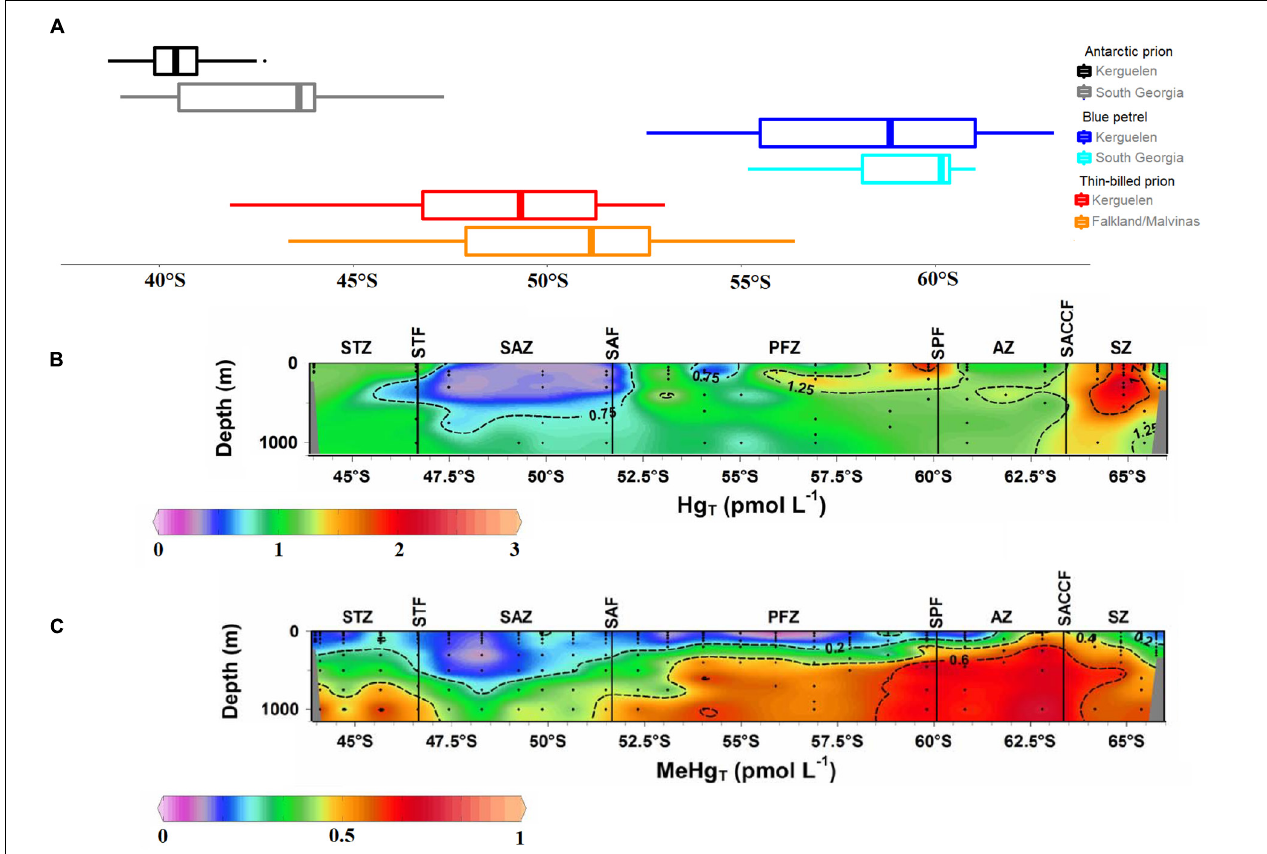
FIGURE 2 | (A) Latitudinal distribution of geolocator tracked Blue Petrels, Thin-billed Prions, and Antarctic Prions during the mid-winter months (June to August), and a mercury transect shown for comparison: (B) total mercury and (C) methyl mercury concentrations along a transect from Hobart to the Antarctic (adapted